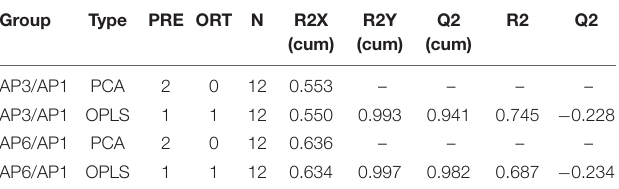
TABLE 1 | Each parameter of PCA model.